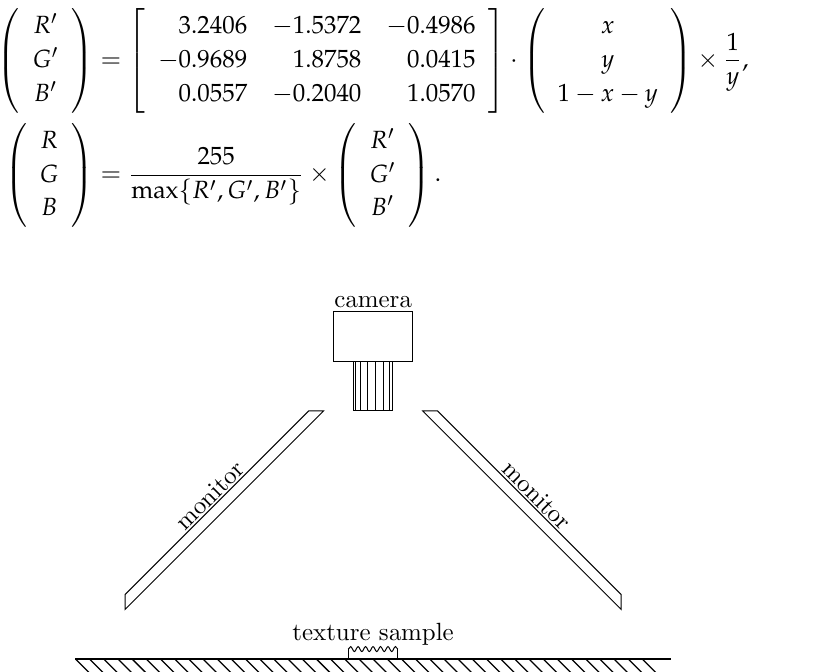
Figure 3. Scheme of the acquisition setup used to take the images in the RawFooT